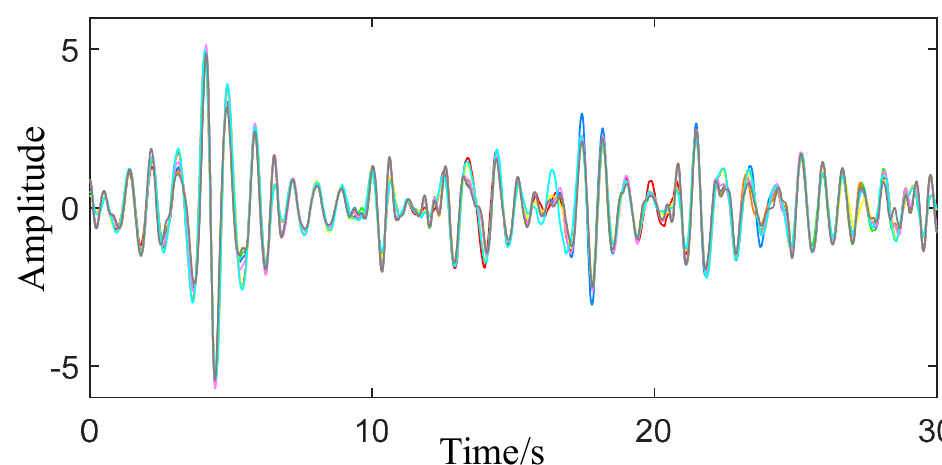
Figure 7. Reconstructed respiratory signal.